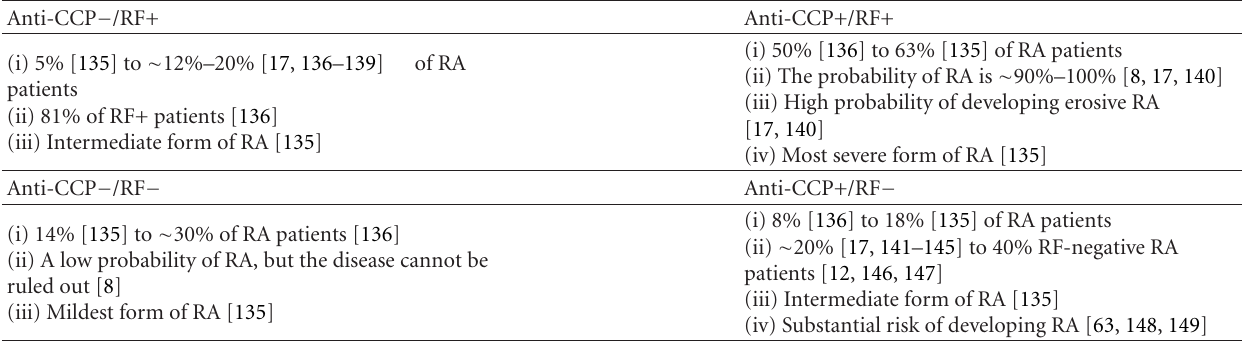
Table 5: Characteristics of patients positive and negative for anti-CCP and rheumatoid